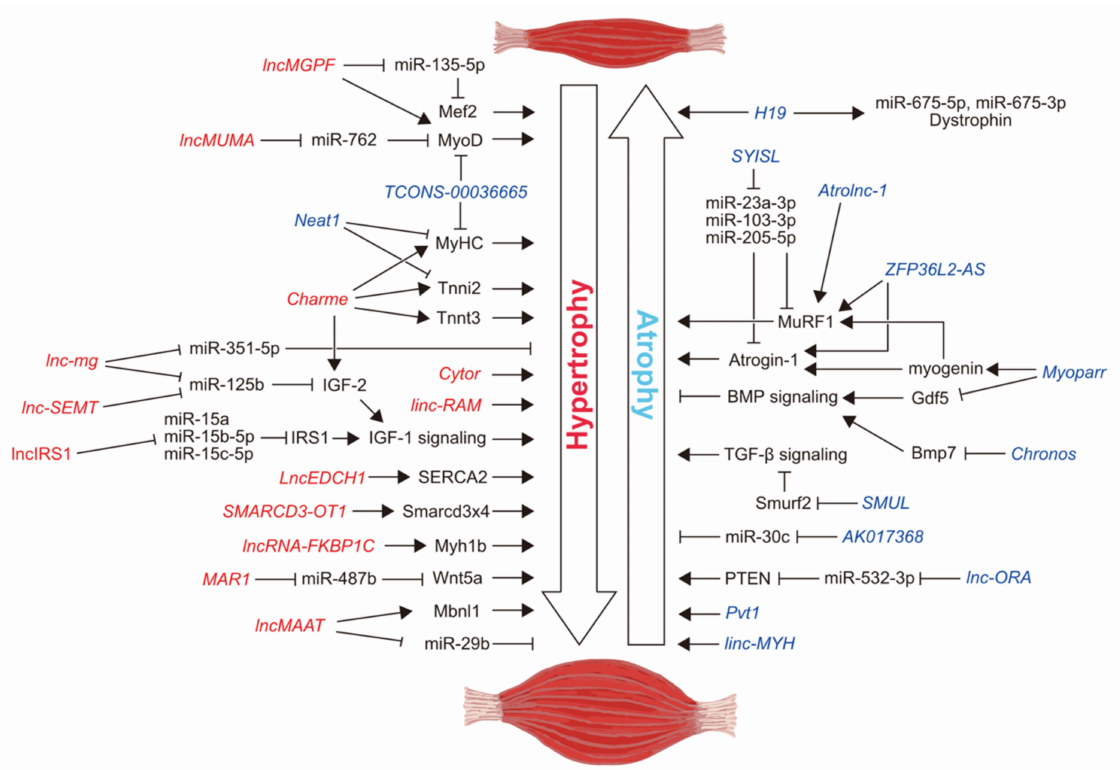
Figure 1. Schematic representation of the lncRNAs involved in the regulation of skeletal muscle mass. Based on the results from in vivo experiments (partial in vitro experiments are included for ceRNAs), lncRNAs increasing muscle mass are represented in red. lncRNAs decreasing muscle mass are represented in